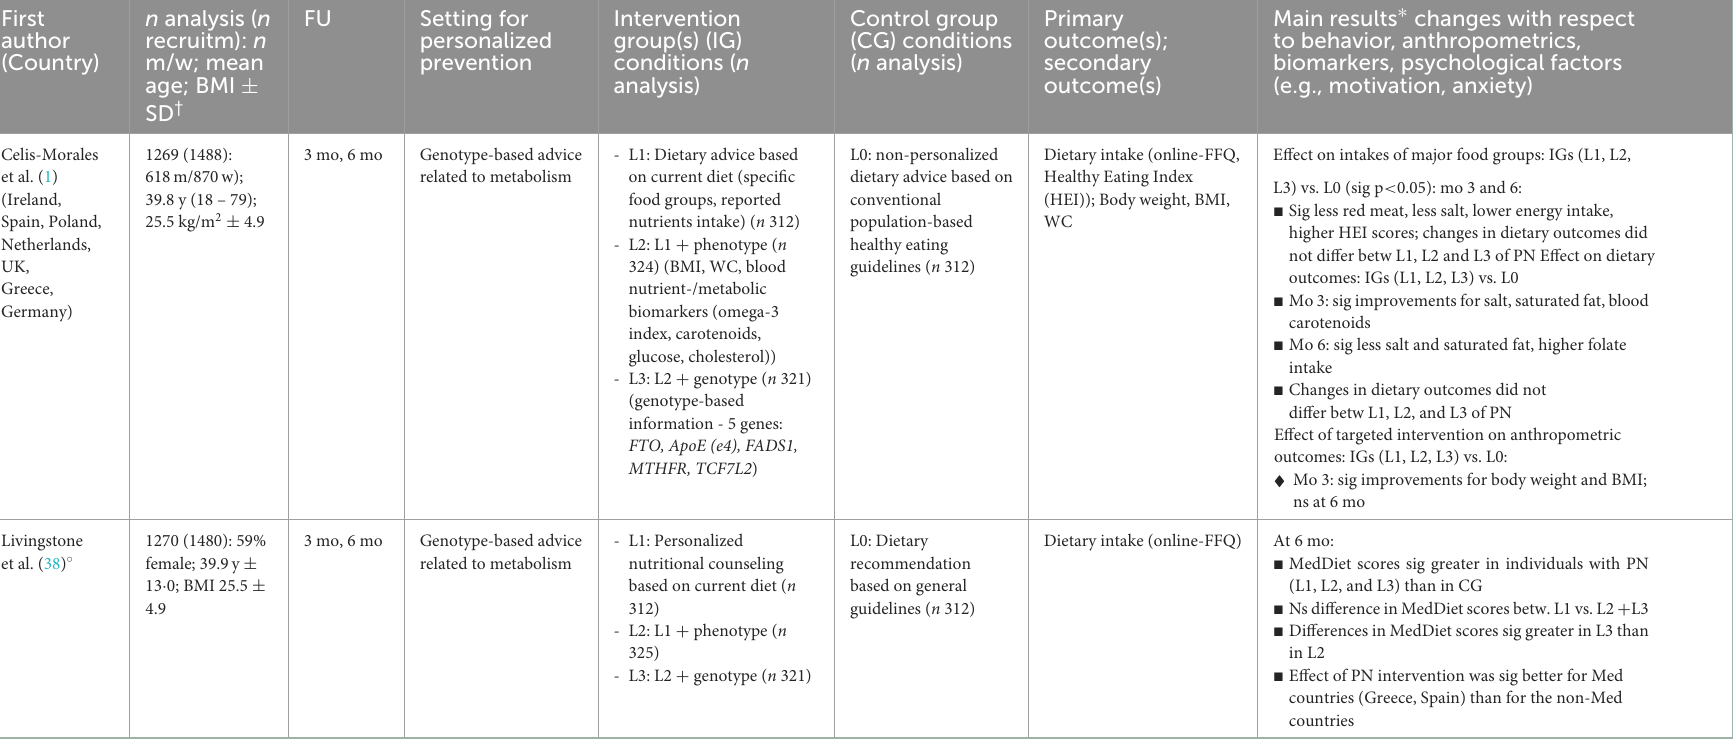
TABLE 2 Effects of personalized prevention based on current diet, phenotype and/or genotype on behavior, anthropometrics and biomarkers – An overview of